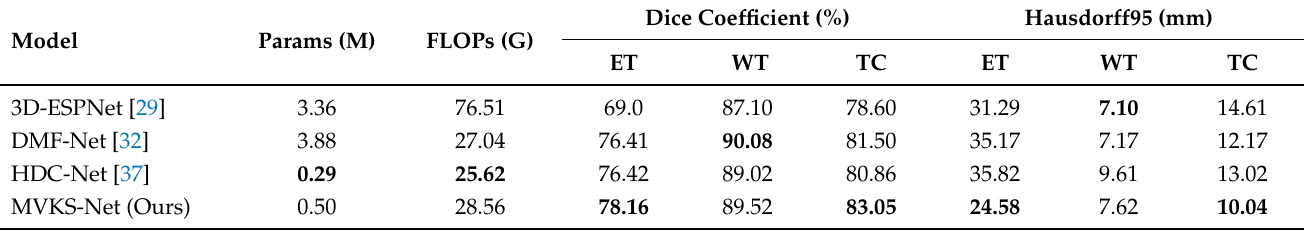
Table 4. Comparison of segmentation results of various lightweight networks on BraTS2020 validation